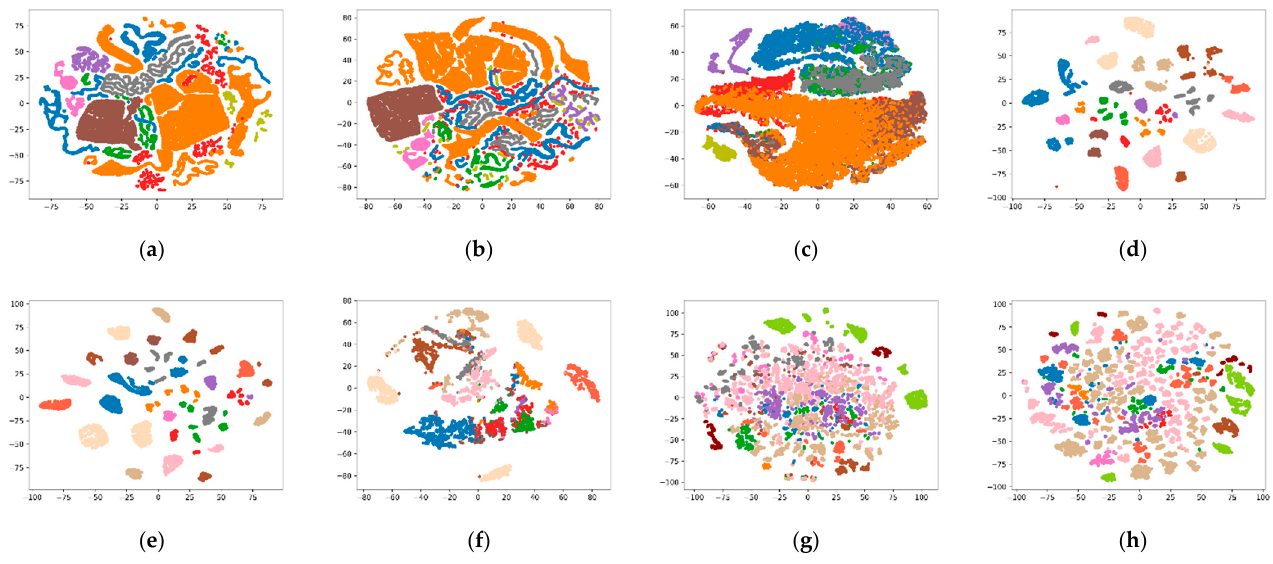
Figure 5. Feature distribution of pixels with fusion feature, spectral feature and spatial feature for the Pavia University dataset and Kennedy Space Center, and fusion feature for HyRANK dataset. ( a ) Fusion feature-PaviaU; ( b ) spatial feature- PaviaU; ( c ) spectral feature-PaviaU; ( d ) fusion feature-KSC; ( e ) spatial feature-KSC; ( f ) spectral feature-KSC; ( g ) fusion feature-Loukia; and ( h ) fusion feature-Dioni.